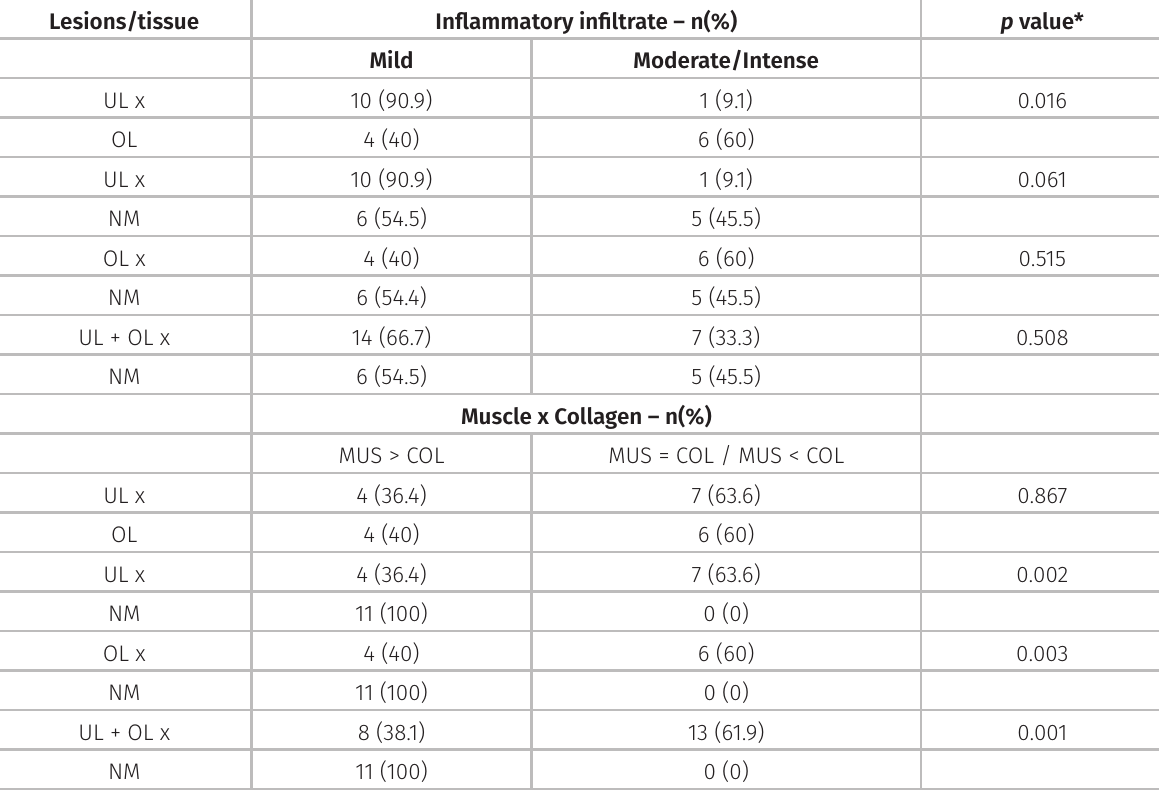
Table I. Associations between the different lesions and inflammatory infiltrate and distribution of muscle tissue and collagen.